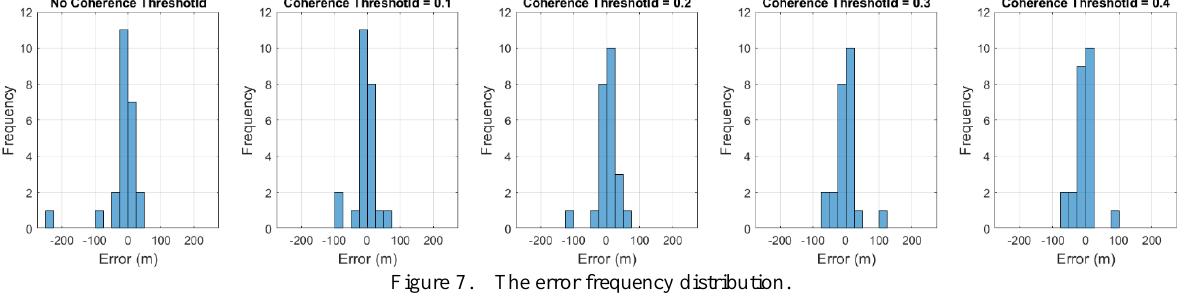
Figure 7. The error frequency distribution.